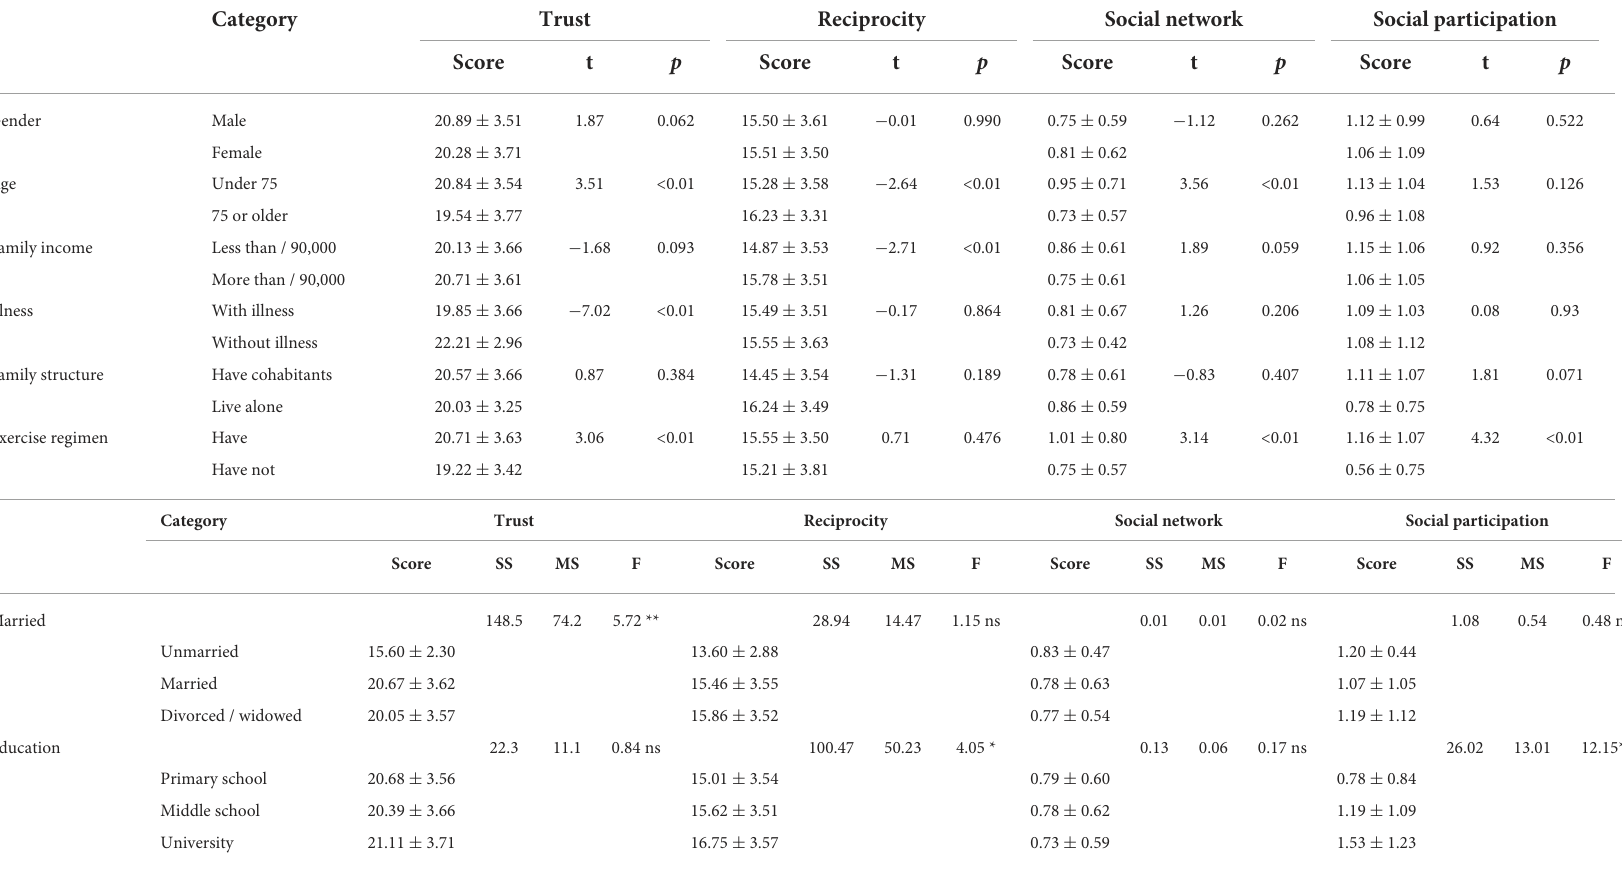
TABLE 4 Relationship between basic attributes and social